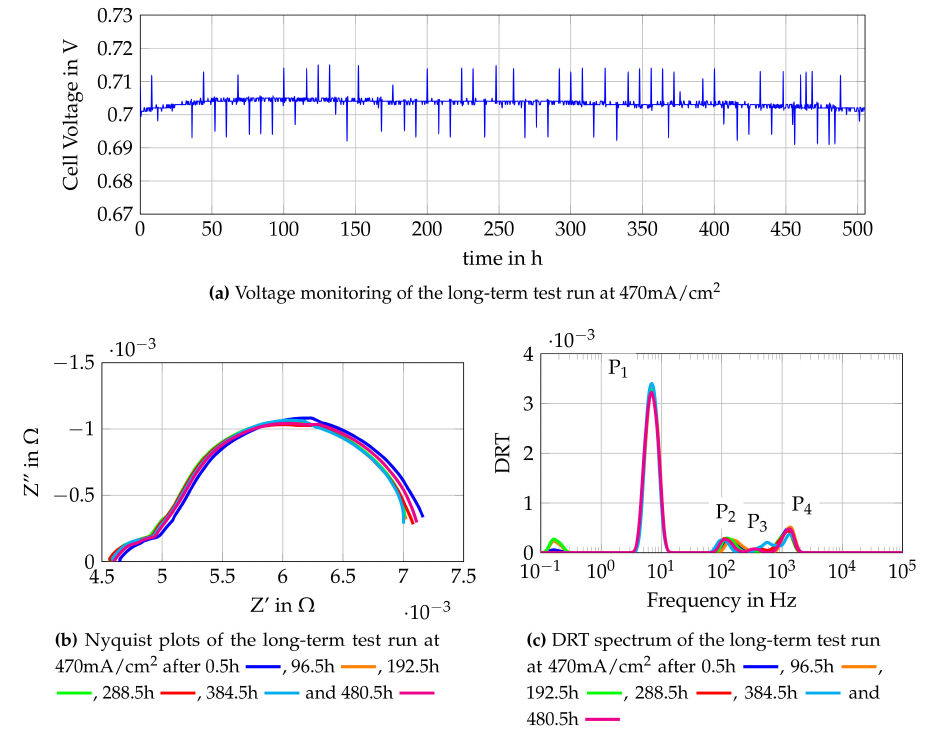
Figure 14. Monitoring data of the single cell fuelled with Comp. 8a at 470 mA/cm 2